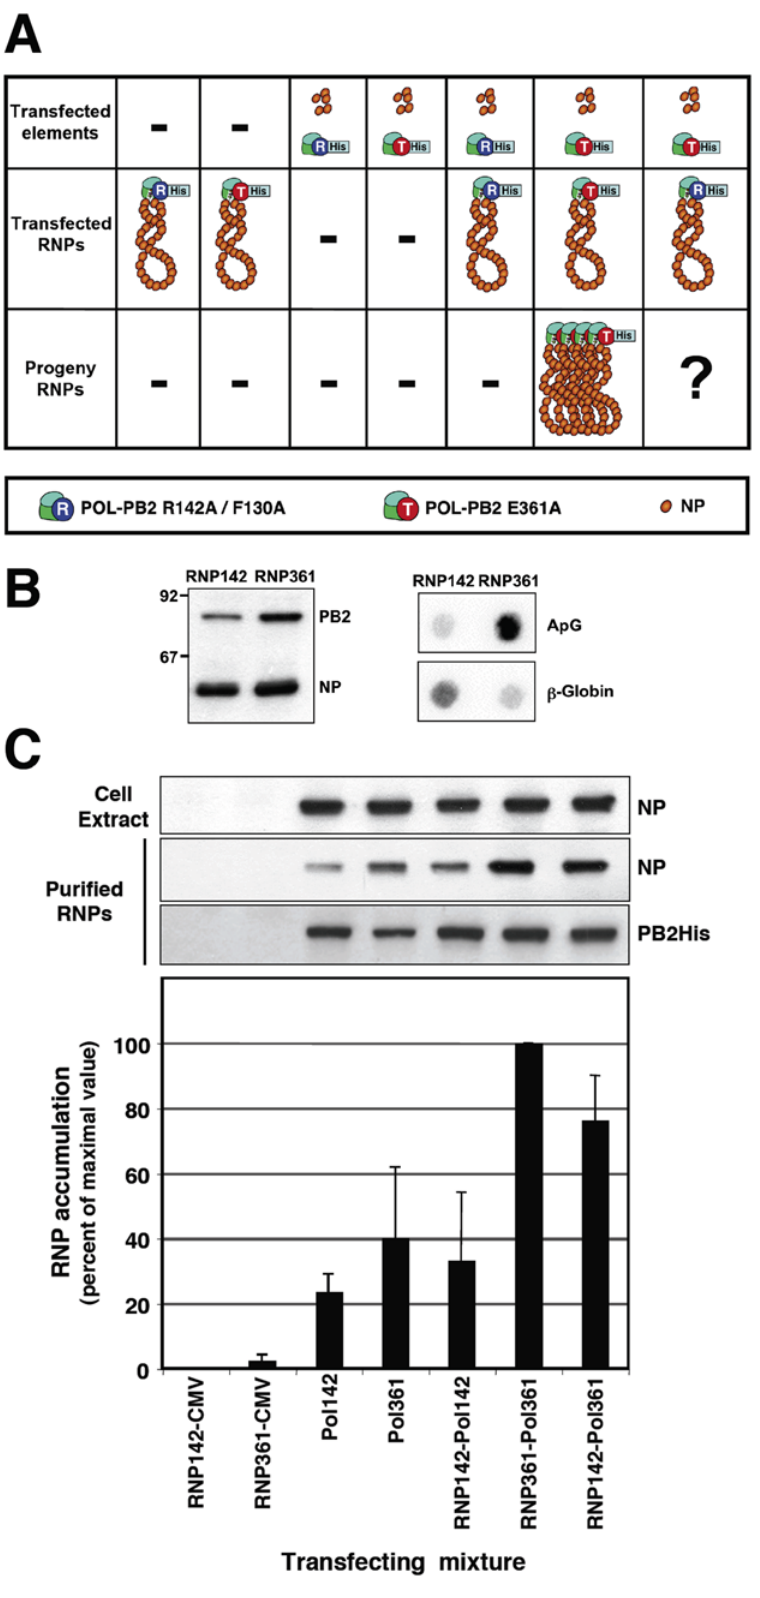
Figure 3. Replication of RNPs by a soluble polymerase complex intrans . (A) Cultures of HEK293T cells were transfected with plasmids expressing the NP and various combinations of the polymerase subunits as indicated in the diagram. In some cases, purified RNPs containing replication-deficient or transcription-deficient polymerase were also transfected. The expected progeny RNPs are also depicted, depending on the